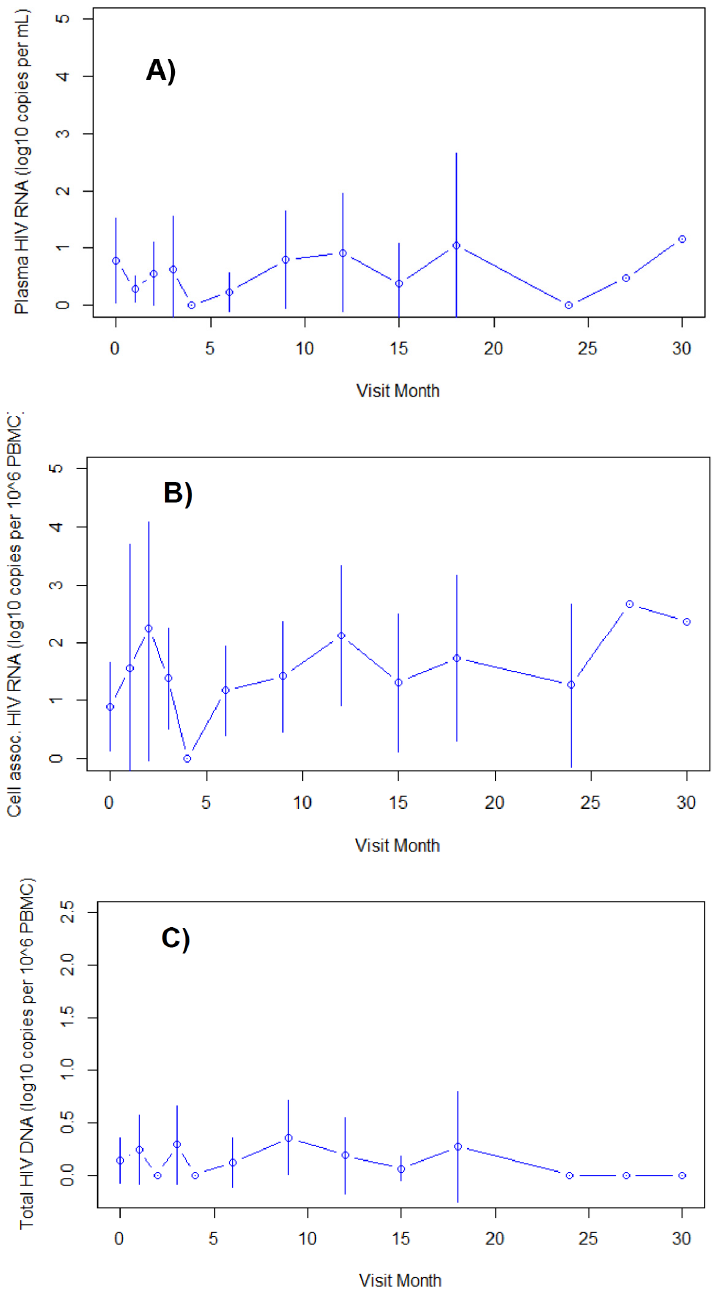
Figure 2. HIV reservoir parameters (means and 95% confidence intervals) for untreated HIV elite controller participants by month of treatment. Panels represent: ( A ) plasma HIV RNA by ultrasensi- tive assay; ( B ) cell-associated HIV RNA; and ( C ) cell-associated total HIV DNA. Points to the right without error bars represent single